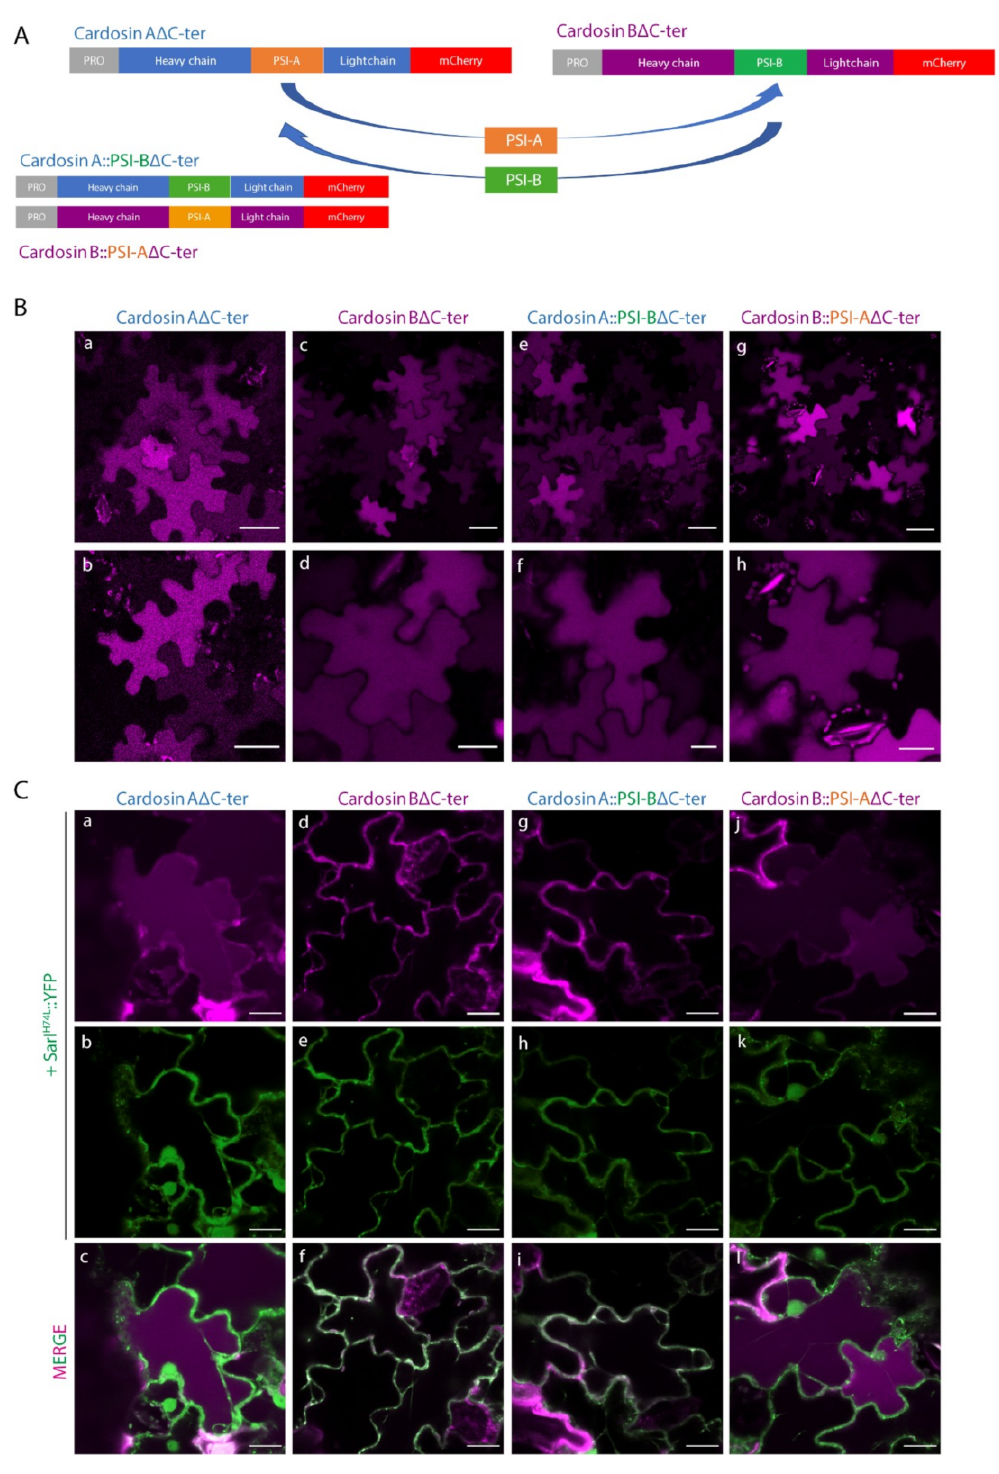
Figure 2. Subcellular localization of cardosins A and B and their PSI-swapped versions in N. tabacum epidermal cells. ( A ) Schematic representation of the fusion proteins used in this assay. ( B ) Expression in tobacco epidermal cells evidencing the vacuolar localization of all fusion proteins: a, b–Cardosin A ∆ C-ter; c, d–Cardosin B ∆ C-ter; e, f–CardosinA::PSIB ∆ C-ter; g, h-CardosinB::PSIA ∆ C-ter. ( C ) Co-expression of the dominant negative mutant SarI H74L ::YFP with: a–c-Cardosin A ∆ C-ter; d–f-Cardosin B ∆ C-ter; g–i-CardosinA::PSIB ∆ C-ter; j–l-CardosinB::PSIA ∆ C-ter. Note the di ff erences in vacuolar accumulation depending on the PSI domain present. All observations and images were acquired 3 days post-infiltration. Images were analyzed and processed using ImageJ / Fiji software. Scale bars: ( B )—upper panels, 50 µ m and lower panels 20 µ m; ( C )—20 µ